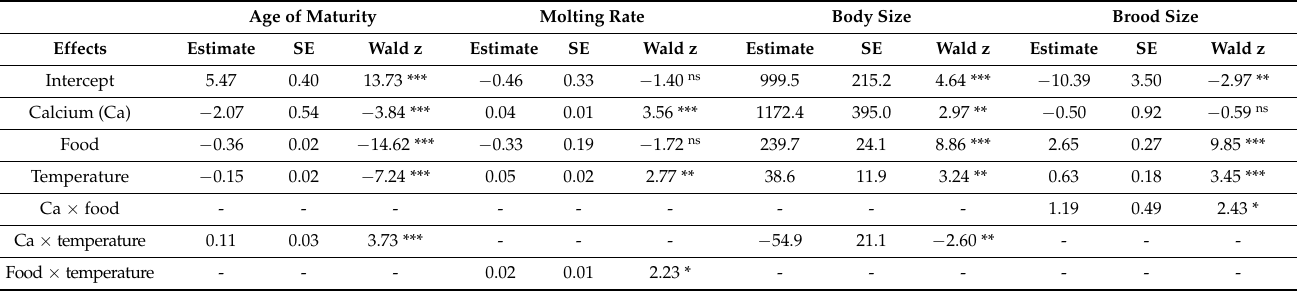
Table 2. Results of the GLMMs performed on development and reproductive traits to test the effects of calcium concentration (log-transformed data), food concentration, and temperature on the age of maturity (log-transformed), moulting rate of juveniles, body size, and average brood size of Daphnia